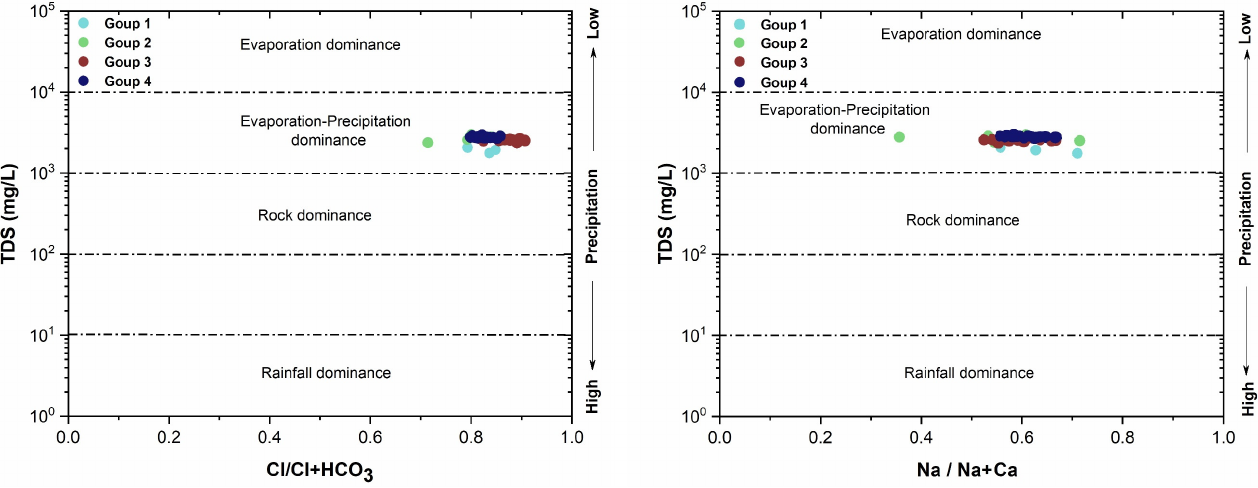
− , and ( B ) Na + -normalized Ca 2+ and Mg 2+ . 3